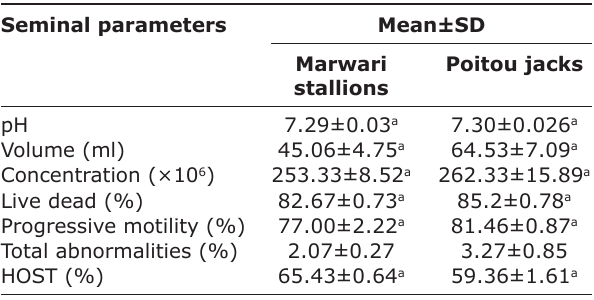
Table-1: Mean±SD seminal attributes of fresh semen ejaculates of the Marwari and Poitou Stallions. Seminal parameters